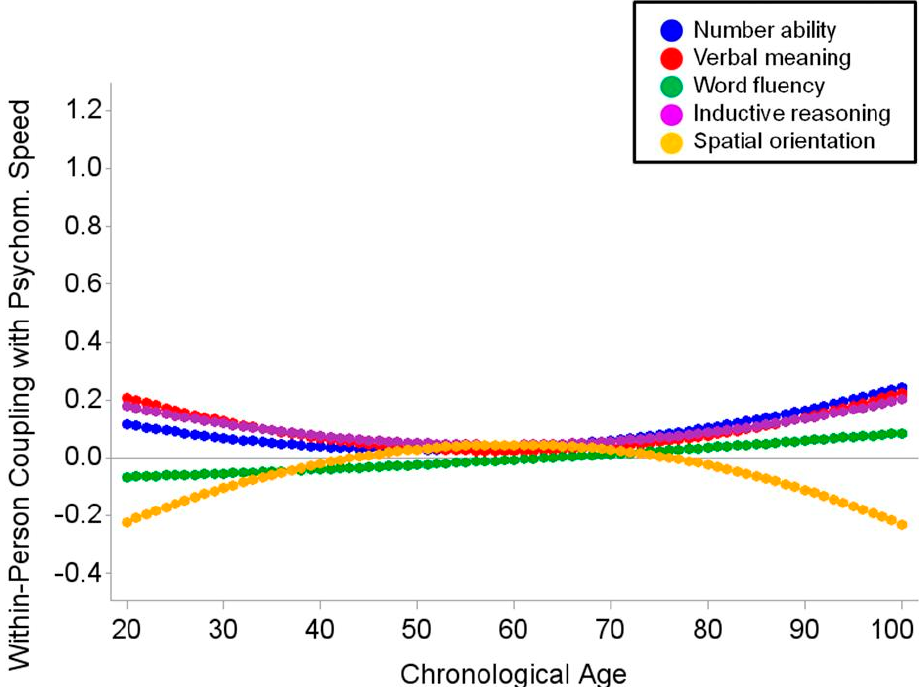
Figure 3. Within-person coupling parameters ( γ 10 ) across chronological age for psychomotor speed and primary mental abilities. All primary mental abilities were associated with psychomotor speed within persons at age 70 years and within-person associations with psychomotor speed linearly increased with age for all primary mental abilities with the exception of word fluency. Furthermore, quadratic age trends were observed for spatial orientation.